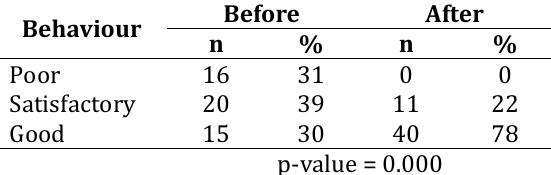
Table 3. The behaviour of nutritional consumption